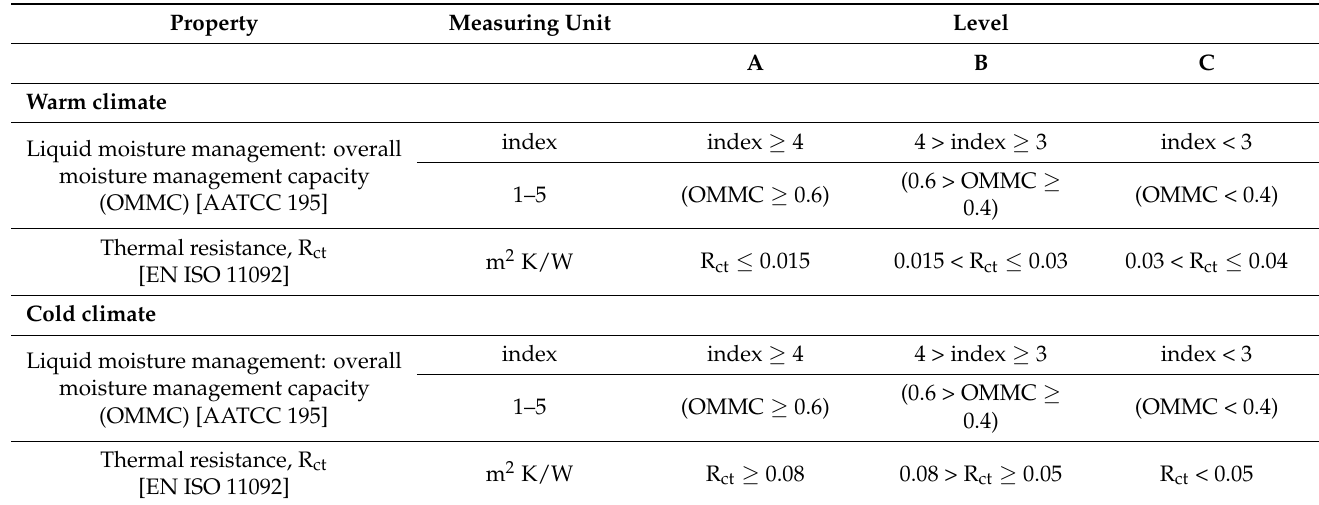
Table 5. Grading of moisture management test (MMT) indices (AATCC 195).